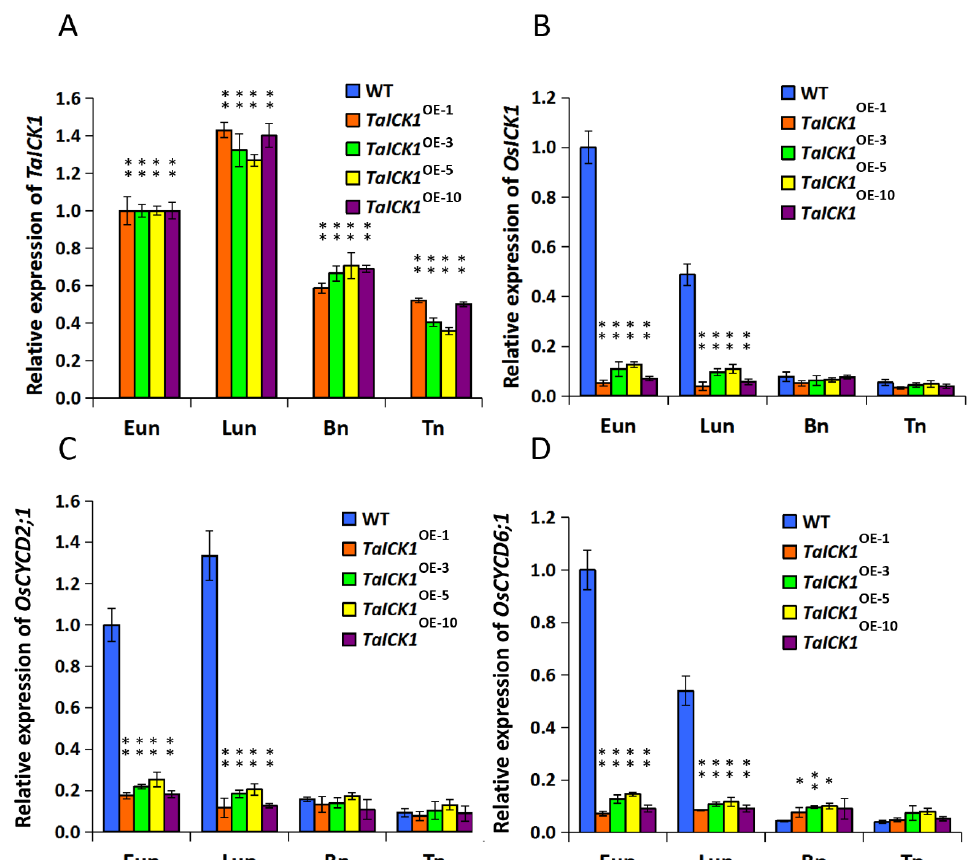
Figure 6. The expression levels of the genes TaICK1 , OsICK1 , OsCYCD2;1 , and OsCYCD6;1 in TaICK1 transgenic rice and wild-type plants. ( A ) The expression levels of TaICK1 . ( B ) The expression levels of OsICK1 . ( C ) The expression levels of OsCYCD2;1 . ( D ) The expression levels of OsCYCD6;1 . Data are presented as the mean ± SD; the mean and error bars indicate SD from OE-1, OE-3, OE-5, and OE-10 with three independent biological and three technical replicates. The mRNA of TaICK1 was not detected in the anthers of wild-type plants; OE: overexpression plants of T 2 ; the number following OE is a code referring to an independent T 2 overexpression plant. The significant di ff erences were assessed using Student’s t-test. * p < 0.05, ** p <